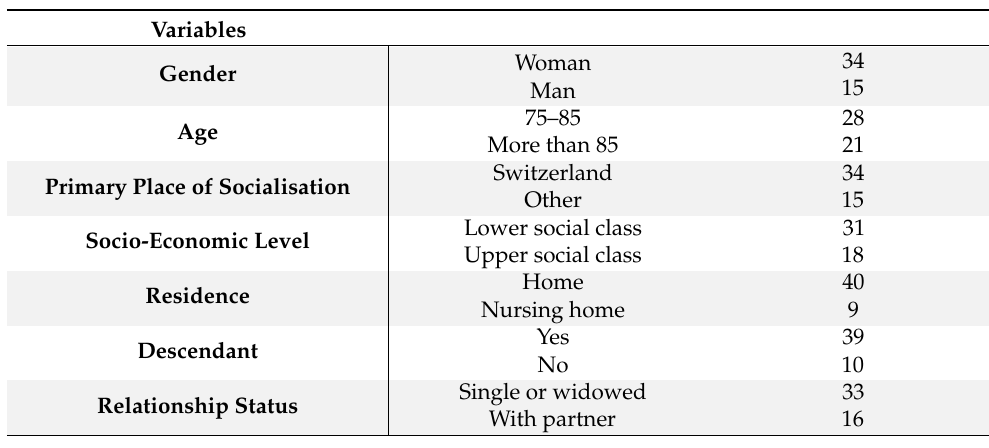
Table 1. Respondents’ socio-demographic